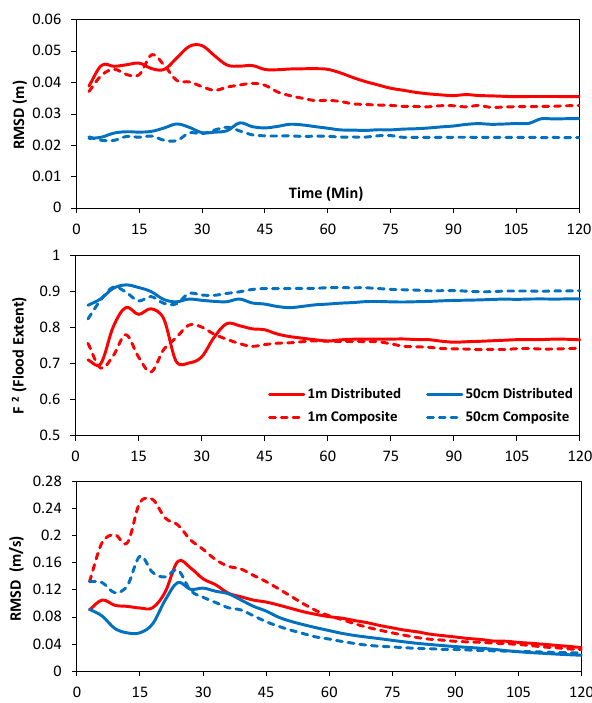
Fig. 11. Evolution of the root-mean-squared difference (RMSD) and F 2 between the benchmark 1x =10cm models with distributed and composite roughness and the coarser 50cm and 1m models throughout the simulation for the water depth and